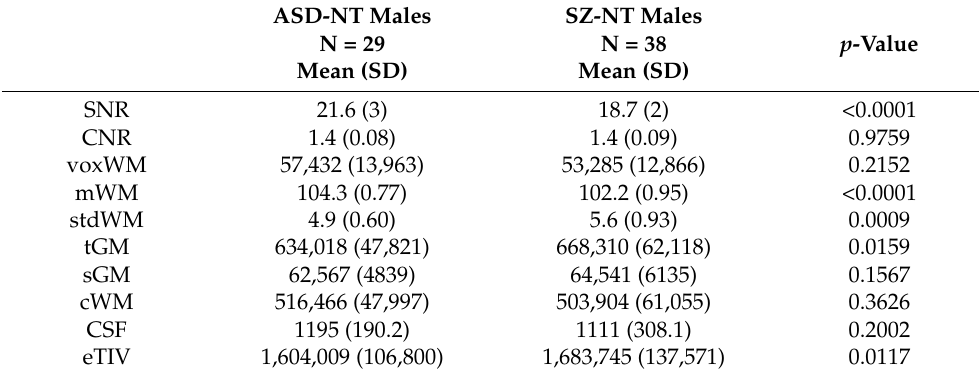
Table 3. FreeSurfer image segmentation quality parameters of ASD-NT and SZ-NT.